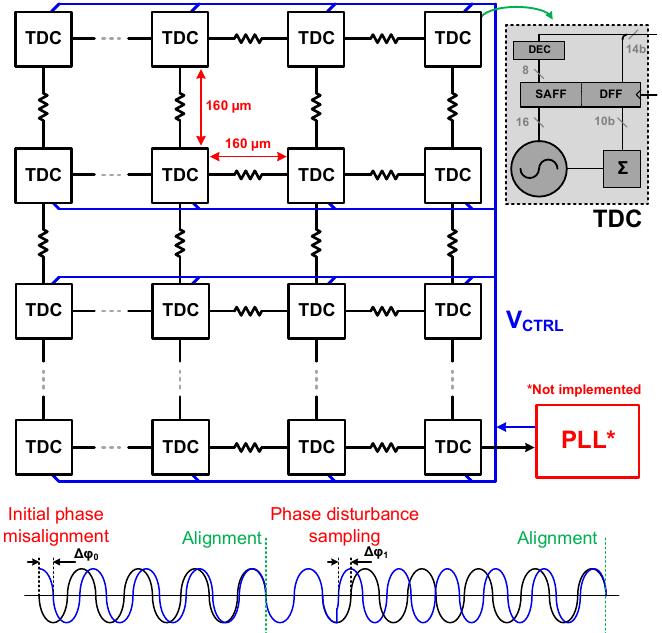
Figure 12. Implemented 8 × 8 mutually-coupled TDC architecture and RO phase misalignment self-correction. PLL: phase-locked